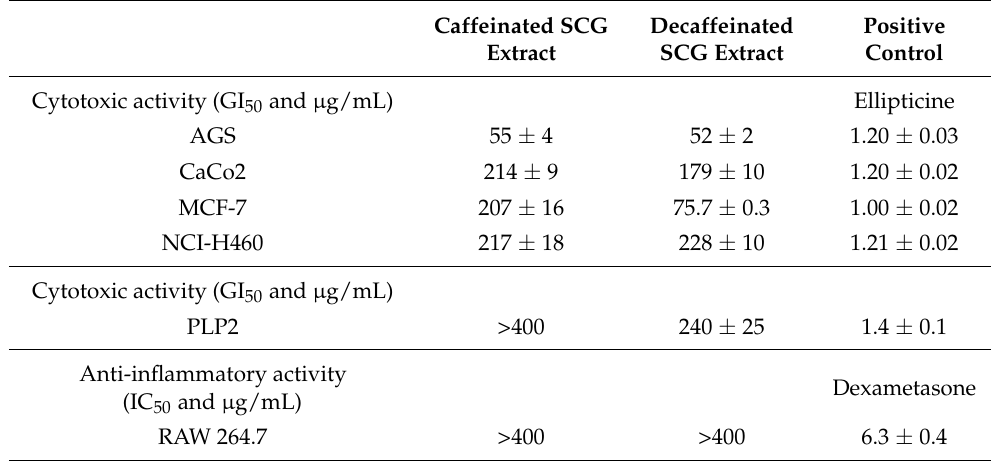
Table 4. Cytotoxic and anti-inflammatory activity of the caffeinated and decaffeinated SCG